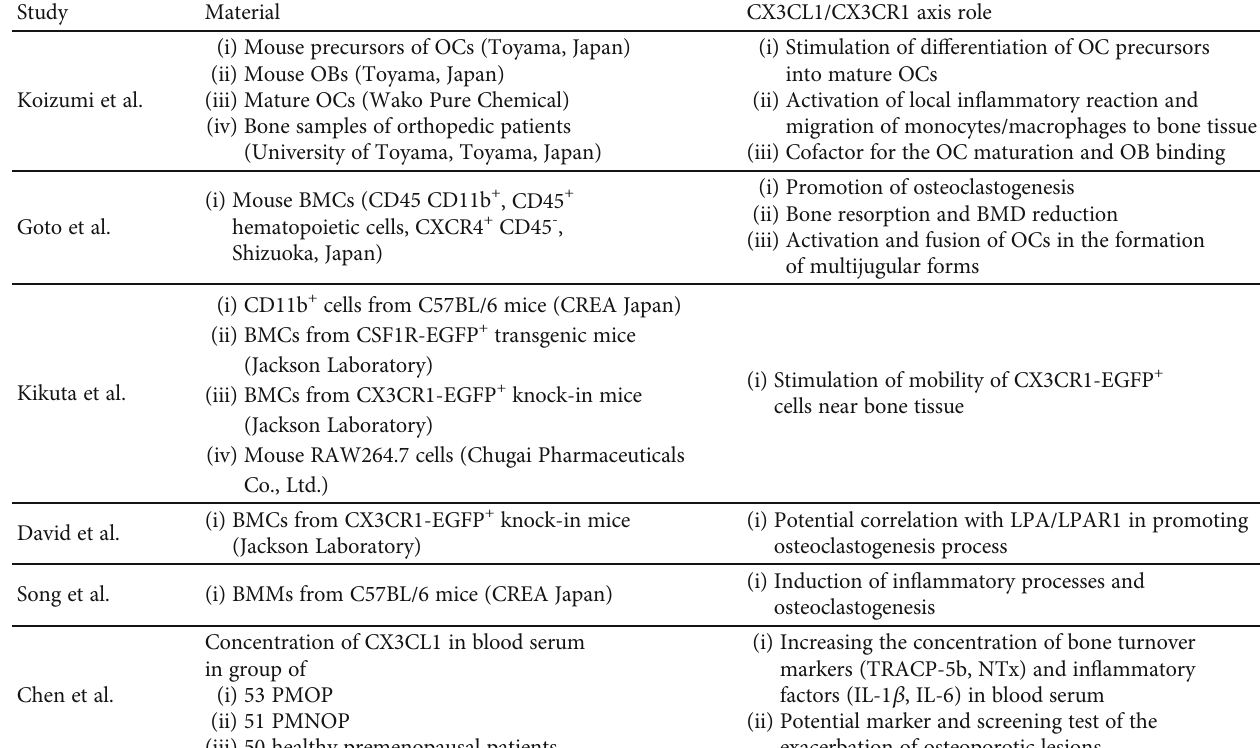
Table 1: The potential role of the CX3CL1/CX3CR1 signaling axis in osteoclastogenesis. OCs: osteoclasts; OBs: osteoblasts; BMCs: bone marrow cells; CD: cluster of di ff erentiation; CXCR4: CXC chemokine receptor type 4; BMD: bone mineral density; CSF1R: colony- stimulating factor 1 receptor; EGFP: enhanced green fl uorescent protein; CX3CR1: CX3C chemokine receptor 1; LPA: lysophosphatidic acid; LPAR1: lysophosphatidic acid receptor type 1; BMMs: bone marrow macrophages; CX3CL1: CX3C motif chemokine ligand 1; PMOP: postmenopausal osteoporosis patients; PMNOP: healthy postmenopausal patients; TRACP-5b: tartrate-resistant acid